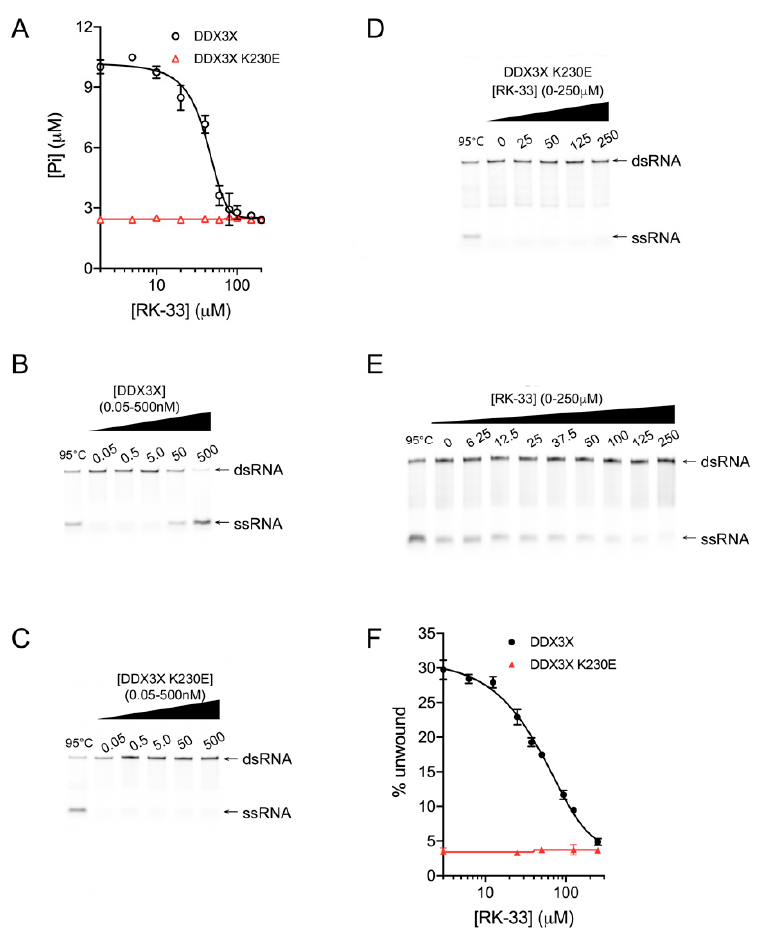
Figure 2. RK-33 inhibits DDX3X helicase and ATPase activity. DDX3X (black) and DDX3X K230E (red) proteins were assessed for their ability to ( A ) hydrolyze ATP and ( B – F ) unwind a synthetic analogue of duplex RNA (poly(I:C)), in the presence of increasing concentrations of RK-33 or equivalent